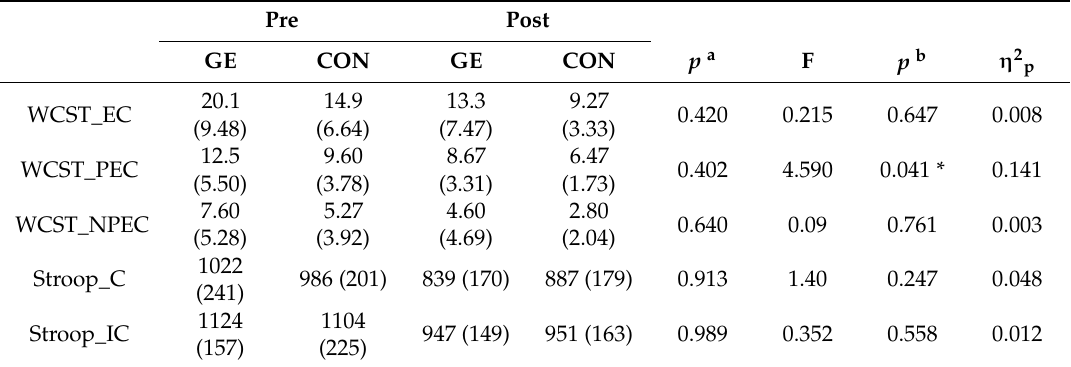
Table 1. WCST and Stroop test changes as a result of 30 min exercise protocol with or without superimposed VR.